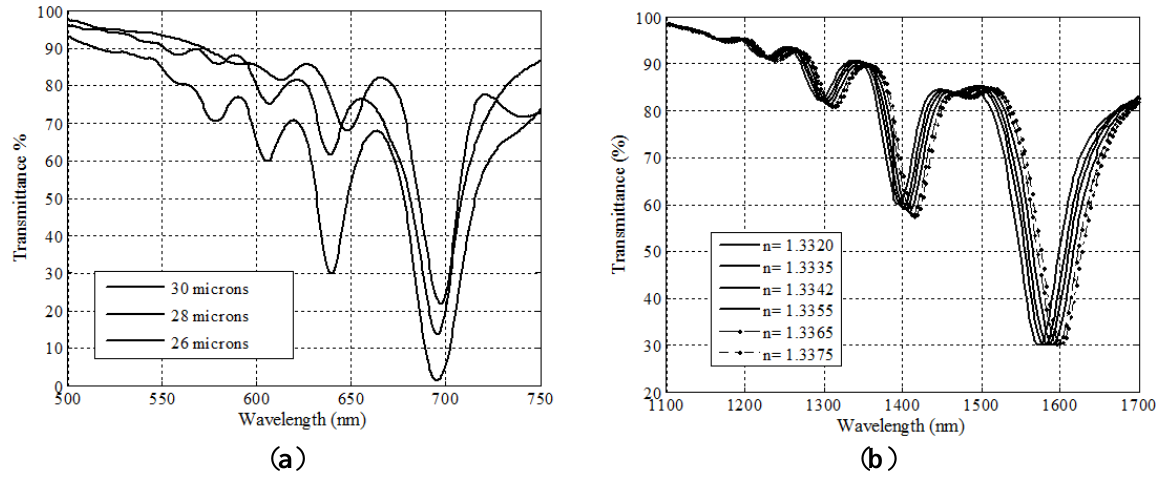
Figure 5. Representative experimental behavior DLUWTs working in extreme spectral regions for aqueous outer media. ( a ) Visible region, shown dependence on waist diameter; ( b ) C-Band, displacement of multiple plasmons with refractive index (figures originally published in [10] and [9], © 2010 and 2014, reproduced with permission from Elsevier).